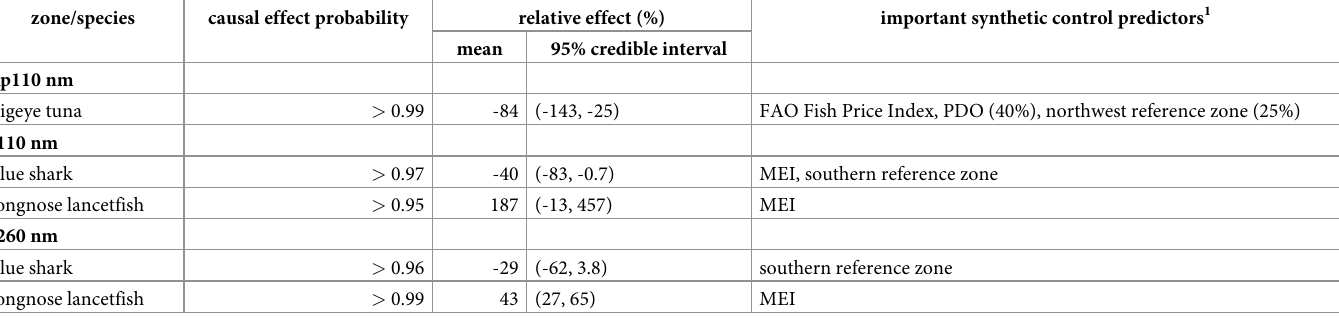
Table 1. Posterior inference summary for the post-intervention period (2009 onwards) for species-specific catch rate predictions deemed here to indicate a signifi- cant MPA attributable causal impact.